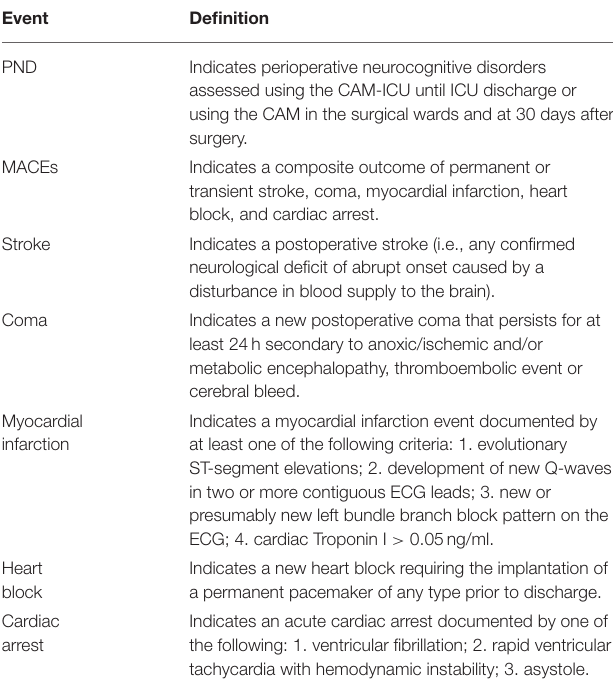
TABLE 2 | Definitions of postoperative complications.